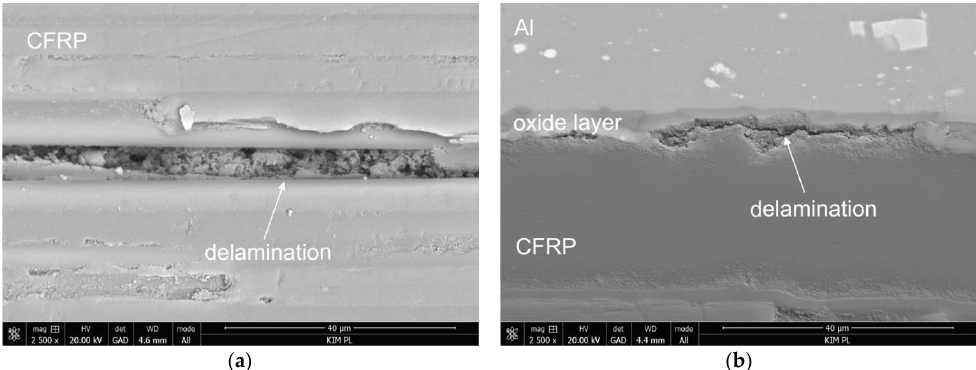
Figure 6. Types of damage in one-sided laminates (Al-C) before ( a ) and after ( b ) hygrothermal conditioning.